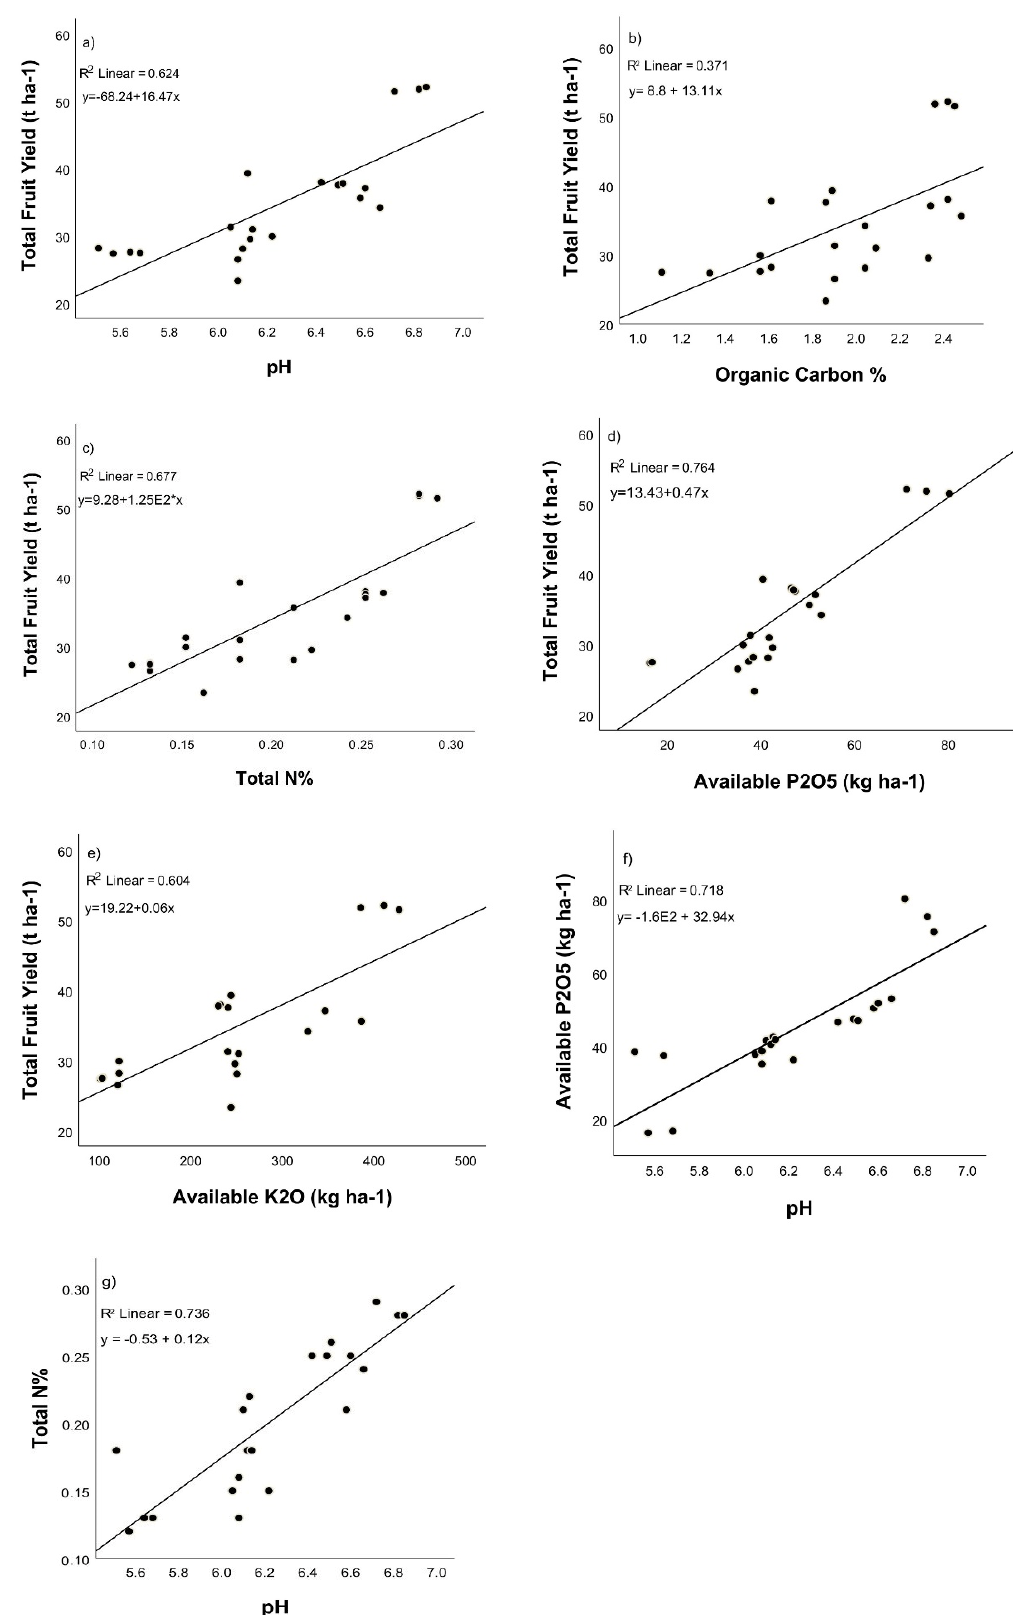
Figure 4. Relationship between soil parameters, i.e., pH, OC, total N, available P, available K, and total fruit yield ( a – e ), and between soil pH vs. available P ( f ) and total N ( g